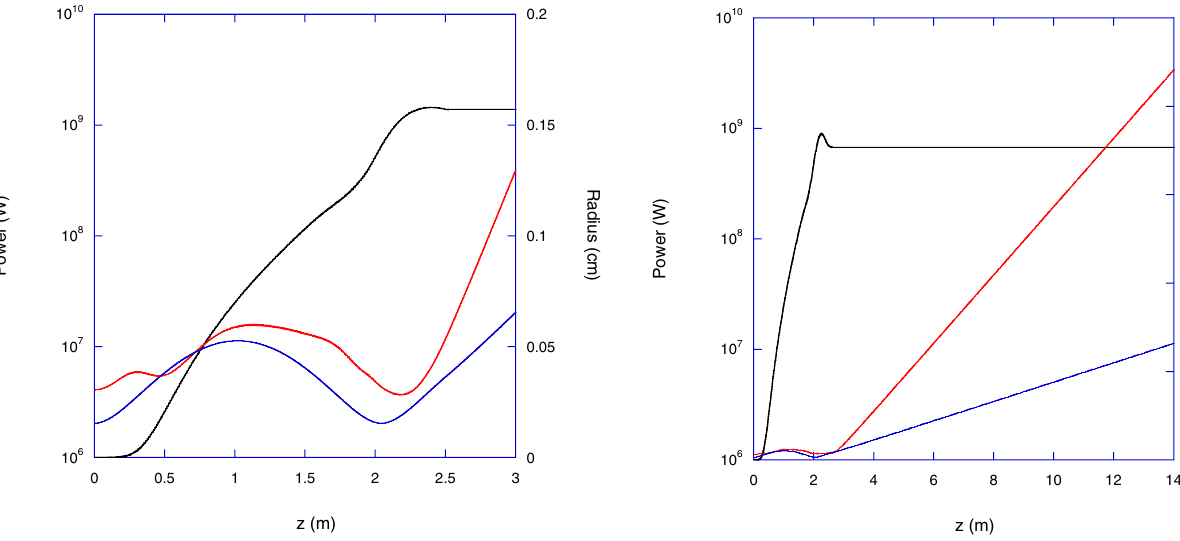
FIG. 4. (Color) Power growth (black), optical beam radius (red), and electron beam radius (blue) inside a scalloped-beam FEL with a two-stage